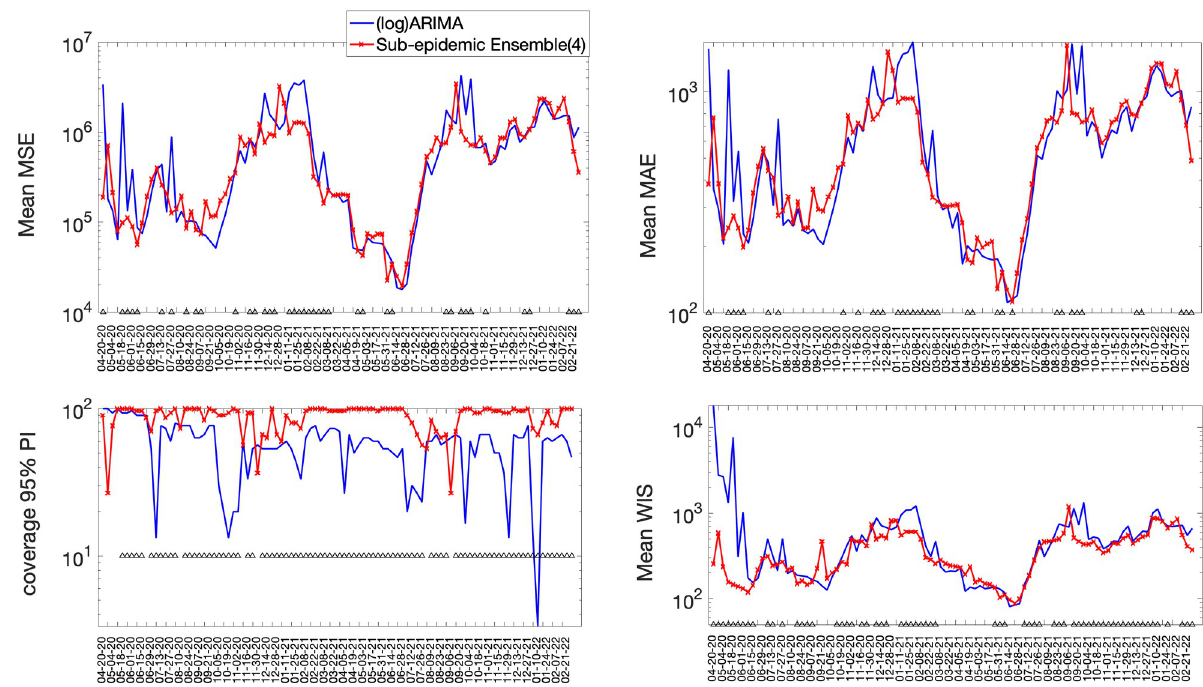
Fig 4. Forecasting performance metrics for the (log) ARIMA and Ensemble(4) models across 98 30-day forecasts. The symbol (^) indicates weekly forecasts where the Ensemble(4) model outperformed the (log) ARIMA model. For example, the Ensemble(4) outperformed the (log) ARIMA model 66.3% of the time in terms of the WIS and 89.8% of the time in terms of the coverage rate of the 95% PI (Figs 3 and 5).